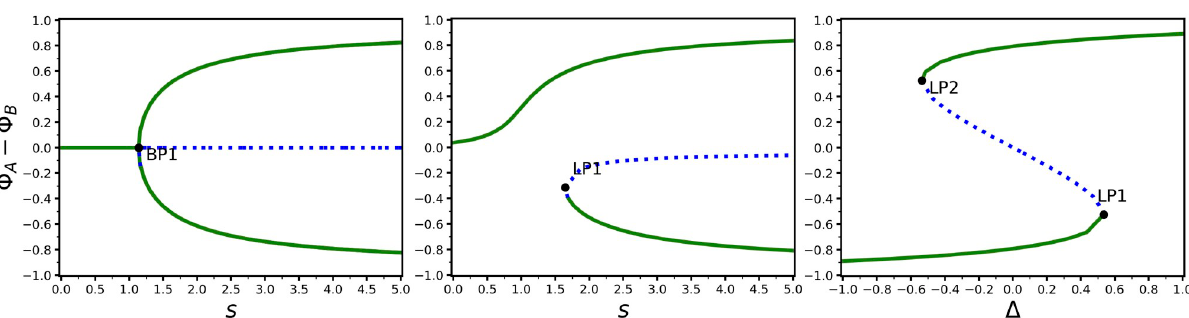
Fig 5. Bifurcation analysis of a nonlinear decision-making model. Bifurcations of the honeybee swarming model [2, 14]. Left: symmetry breaking in the two decision populations through a pitchfork bifurcation, with strength of cross-inhibitory stop-signalling s as the bifurcation parameter (cf. [14] Fig 5i) (parameters Δ = 0.0, μ = 4.0). Centre: unfolding of the pitchfork bifurcation into a saddle-node bifurcation (cf. [14] Fig 5ii) (parameters Δ = 0.1, μ = 4.0). Right: hysteresis loop with option quality difference Δ as the bifurcation parameter (cf. [14] Fig 5iii) (parameters μ = s = 4.0). Solid black lines denote stable branches, dashed blue lines denote unstable